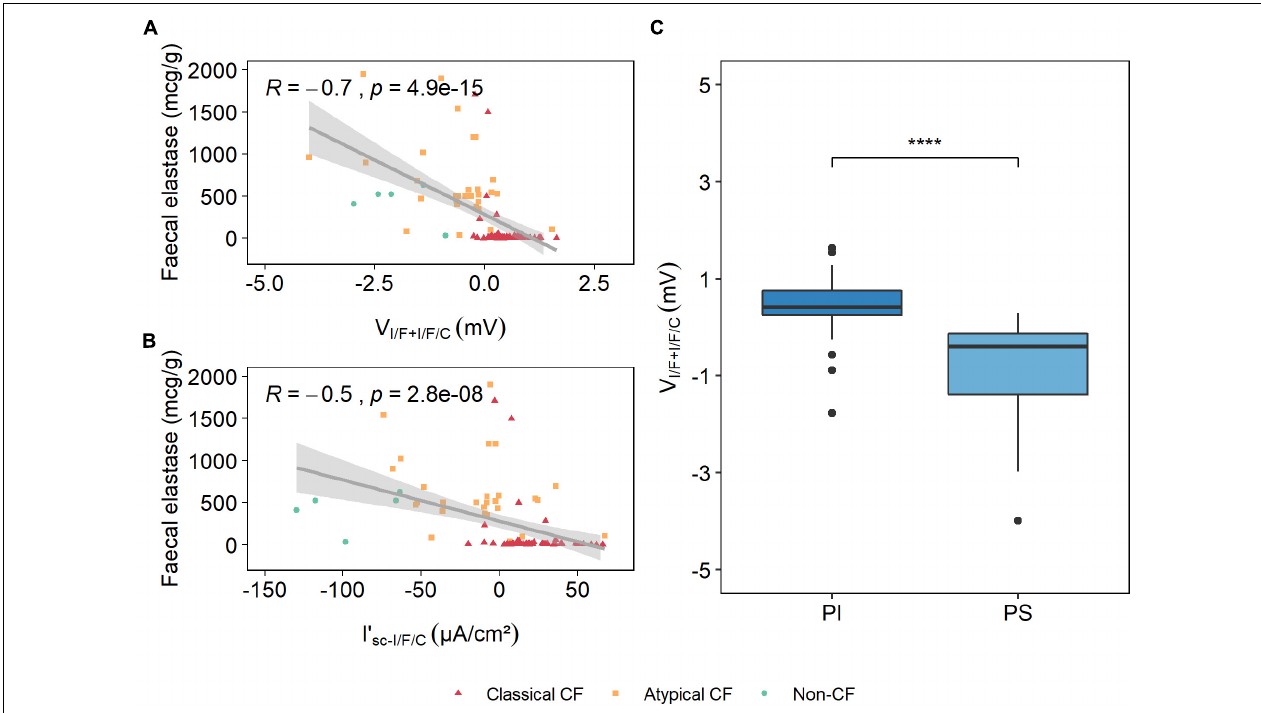
FIGURE 4 | Correlation of fecal elastase E1 (FE-1) values and V I / F + I / F / C and I’ sc − I / F / C . Spearman rho rank correlation analysis showed that there is a strong negative correlation between FE-1 and V I / F + I / F / C , with a correlation coefficient of ∼ 0.7 (A) , whereas FE-1 correlation with I’ sc − I / F / C is moderate, with a coefficient of ∼ 0.5. (B) R represents the correlation coefficient and p represents the p value. (C) The values from the voltage of the maximal activation of CFTR measured in the I’ sc − I / F / C responses were plotted and grouped by the exocrine pancreatic function (PI and PS), and show that PwCF who are PI are associated with higher V I / F + I / F / C values and that PS PwCF are associated with lower V I / F + I / F / C values. [Kruskal–Wallis rank sum test (**** p ≤